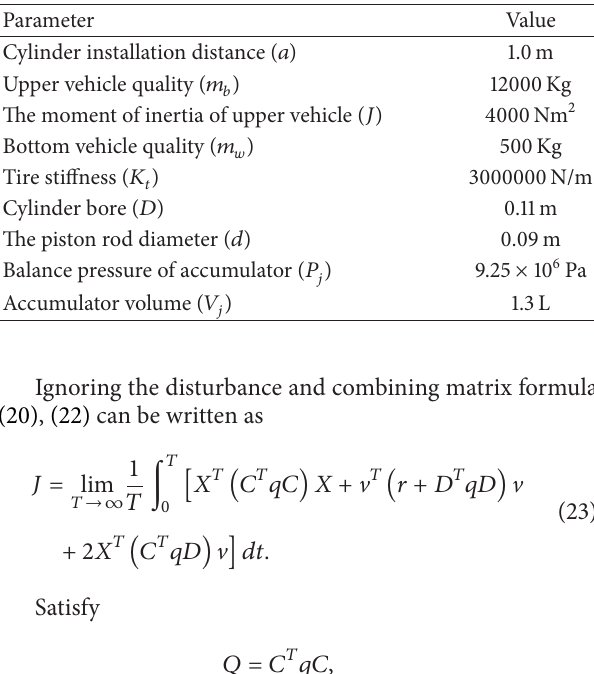
Table 1: Parameters of simulation